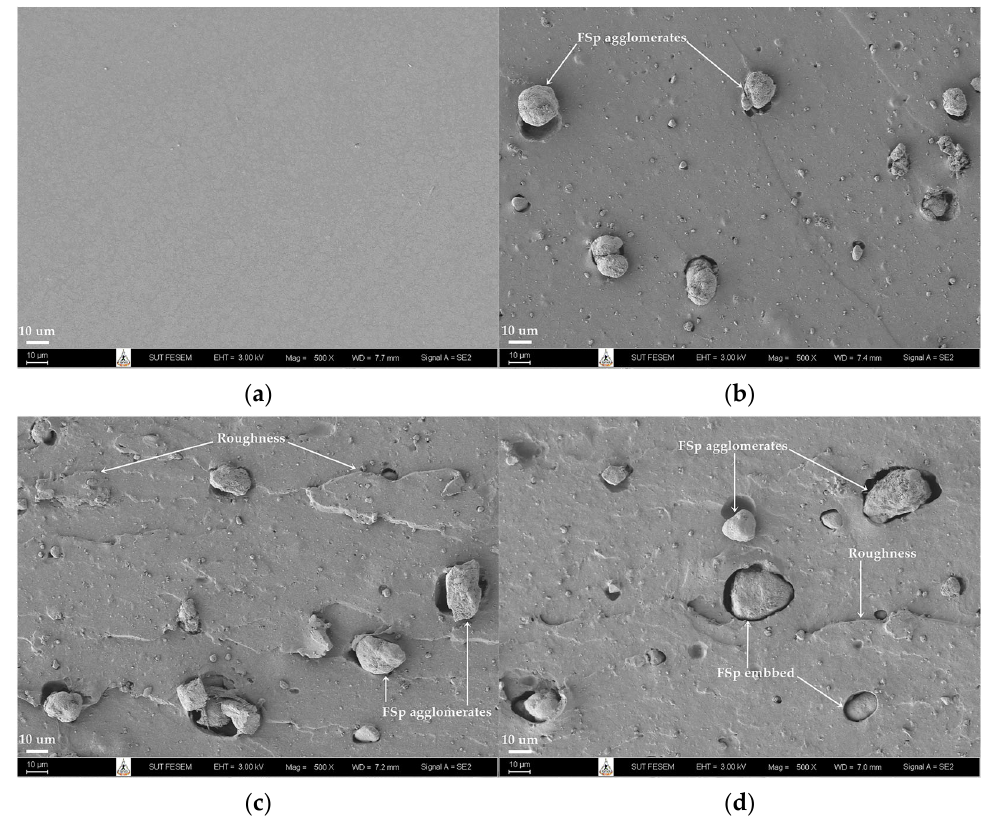
Figure 8. FE ‐ SEM images of ( a ) Unfilled NBR, ( b ) NBR ‐ 5FSp, ( c ) NBR ‐ 10FSp, and ( d ) NBR ‐ 10FSp ‐ Figure 8. FE-SEM images of ( a ) Unfilled NBR, ( b ) NBR-5FSp, ( c ) NBR-10FSp, and ( d ) NBR-10FSp- CA composites. CA